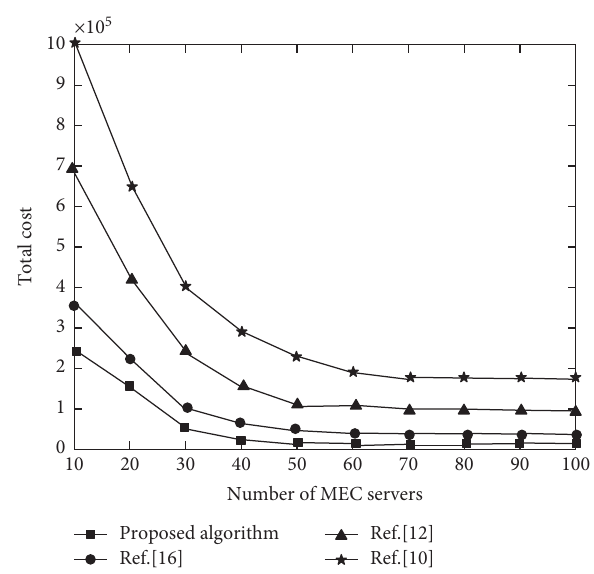
Figure 7: The effect of the number of MEC servers on the total cost.